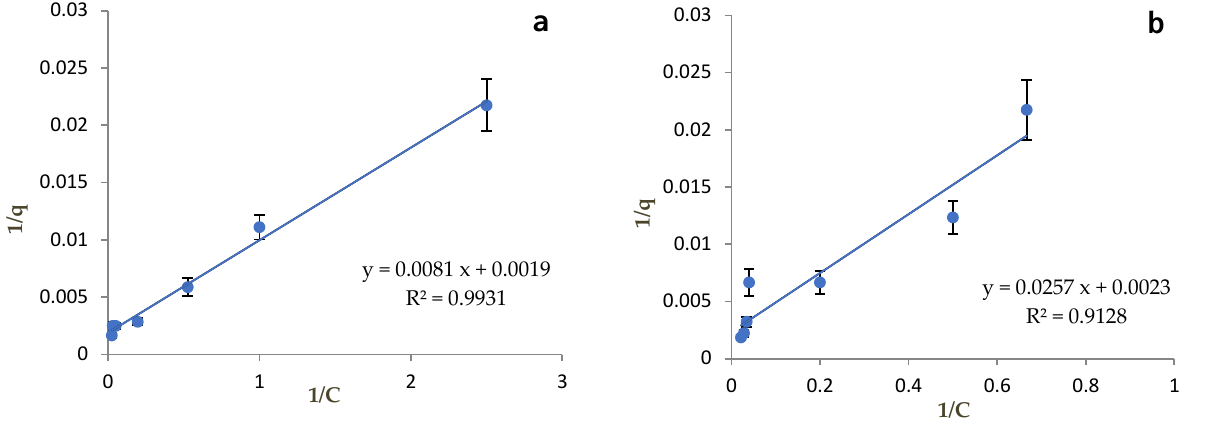
Figure 7. The Langmuir isotherm adsorption of Cu in the presence of Cd in the alkaline soil sample ( a ) and in the acidic soil samples ( b ).